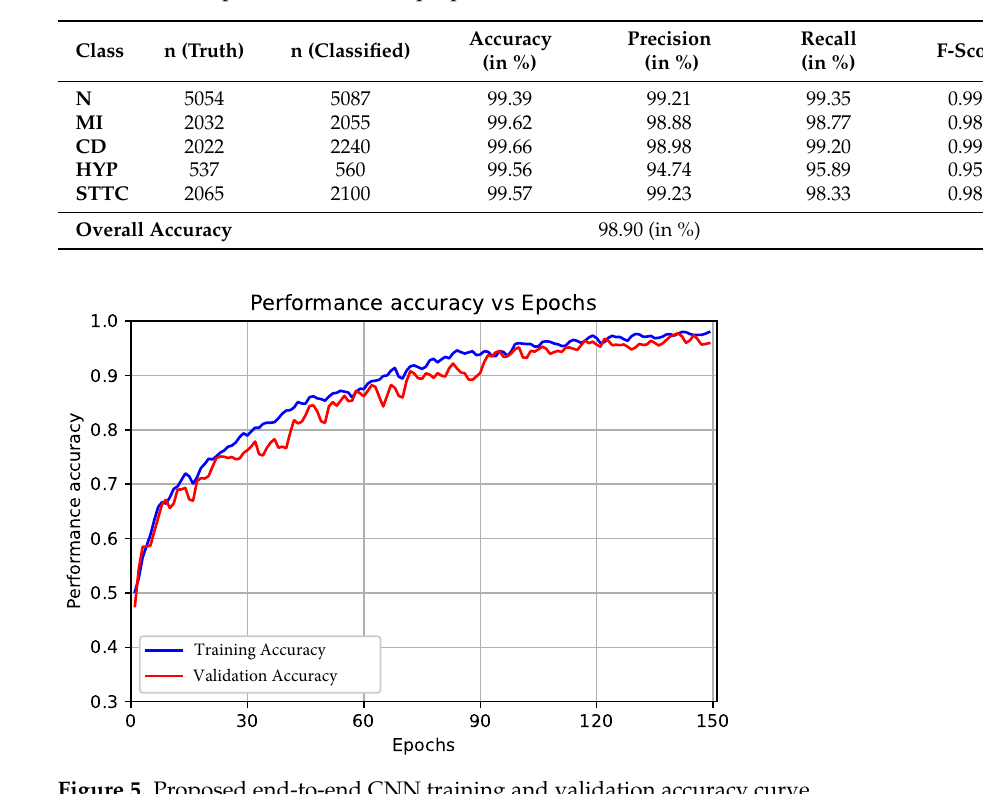
Figure 4. Confusion matrix of the proposed end-to-end CNN model. Table 6. Overall performance of the proposed end-to-end CNN model for each class.